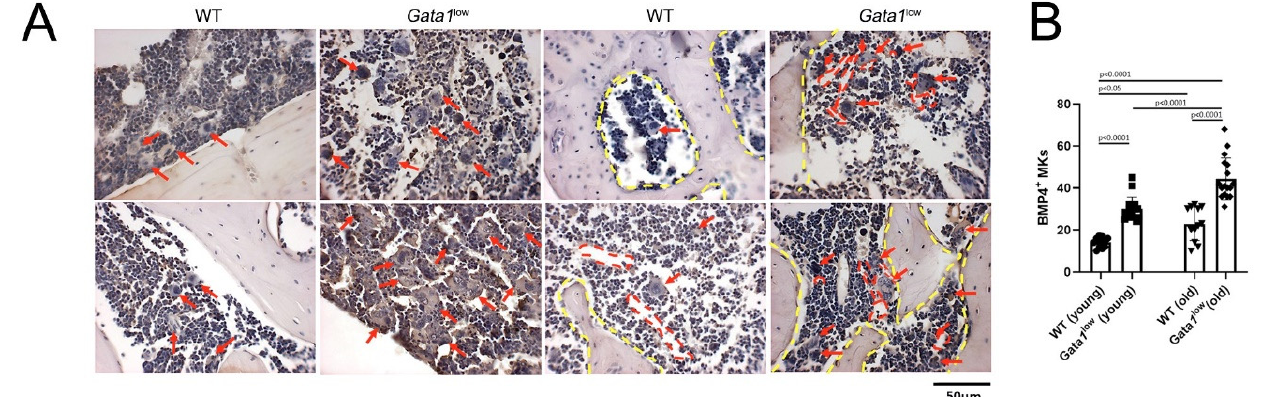
Figure 11. The megakaryocytes in the femur of Gata1 low mice contain high levels of BMP-4 and are localized in close proximity to microvessels and bone trabeculae. ( A ) Representative sections of the femur from two representative wild-type and Gata1 low mice immunostained for BMP-4 and counterstained with hematoxylin. Arrows indicate megakaryocytes, red dashed lines indicate the contour of the microvessels, and yellow dashed lines indicate the contour of the bones. Magnification 40 × . ( B ) Quantification of the megakaryocytes expressing BMP-4 in the bone marrow of young and old wild-type and Gata1 low littermates, as indicated. Results are presented as mean ( ± SD) and as values of individual mice (each dot an individual mouse). P values were calculated with Tukey multiple comparison, and those statistically significant are indicated in the panels. Abbreviations: WT: wild-type; MKs: megakaryocytes, BMP-4; bone morphogenetic protein 4.